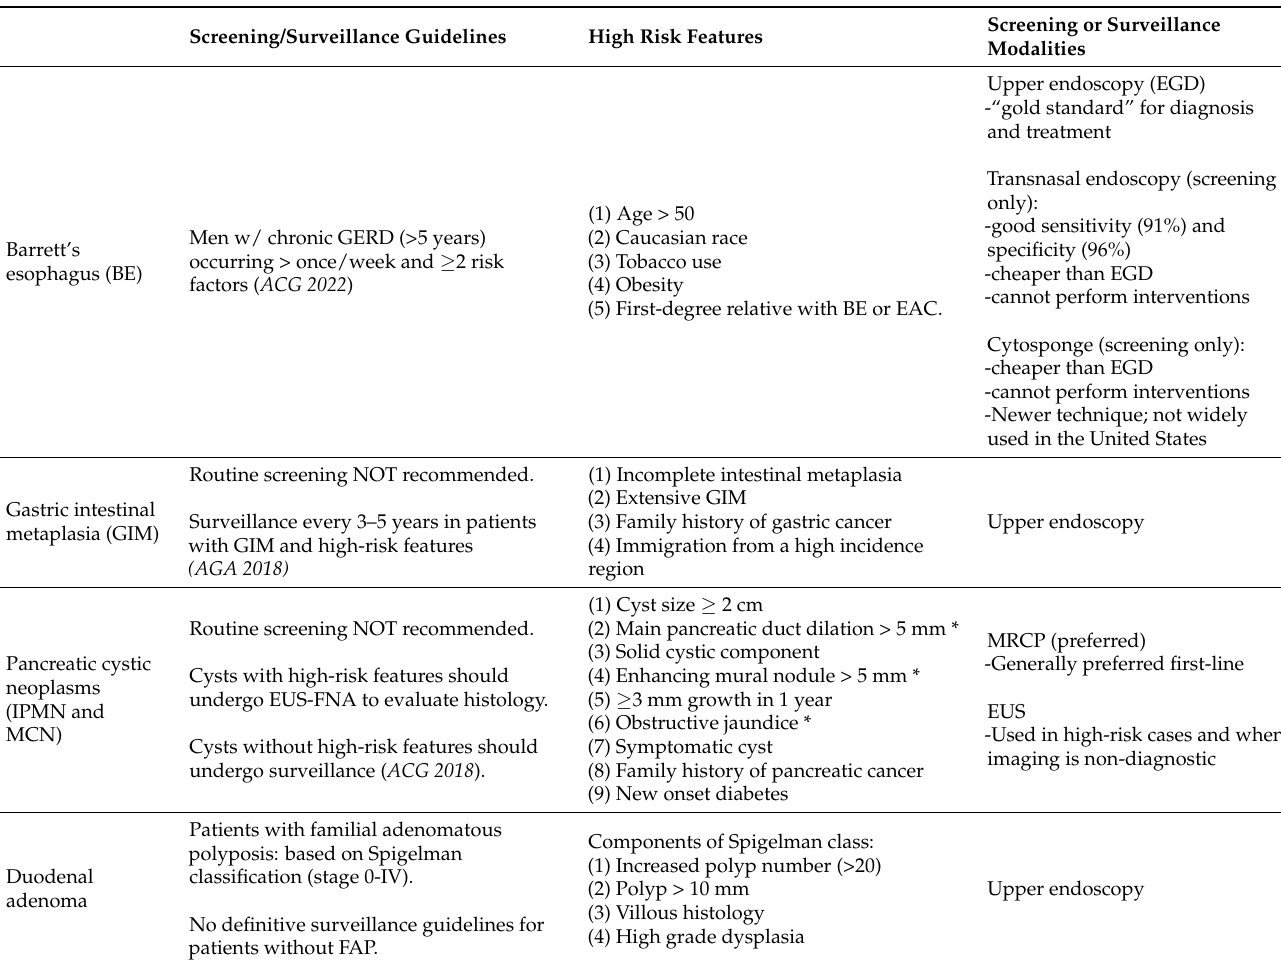
Table 1. Screening Guidelines for pre-malignant upper GI